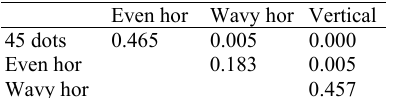
Table 3 p-Values for the significance of the difference in er- ror between pairs of means Even hor Wavy hor Vertical 45 dots